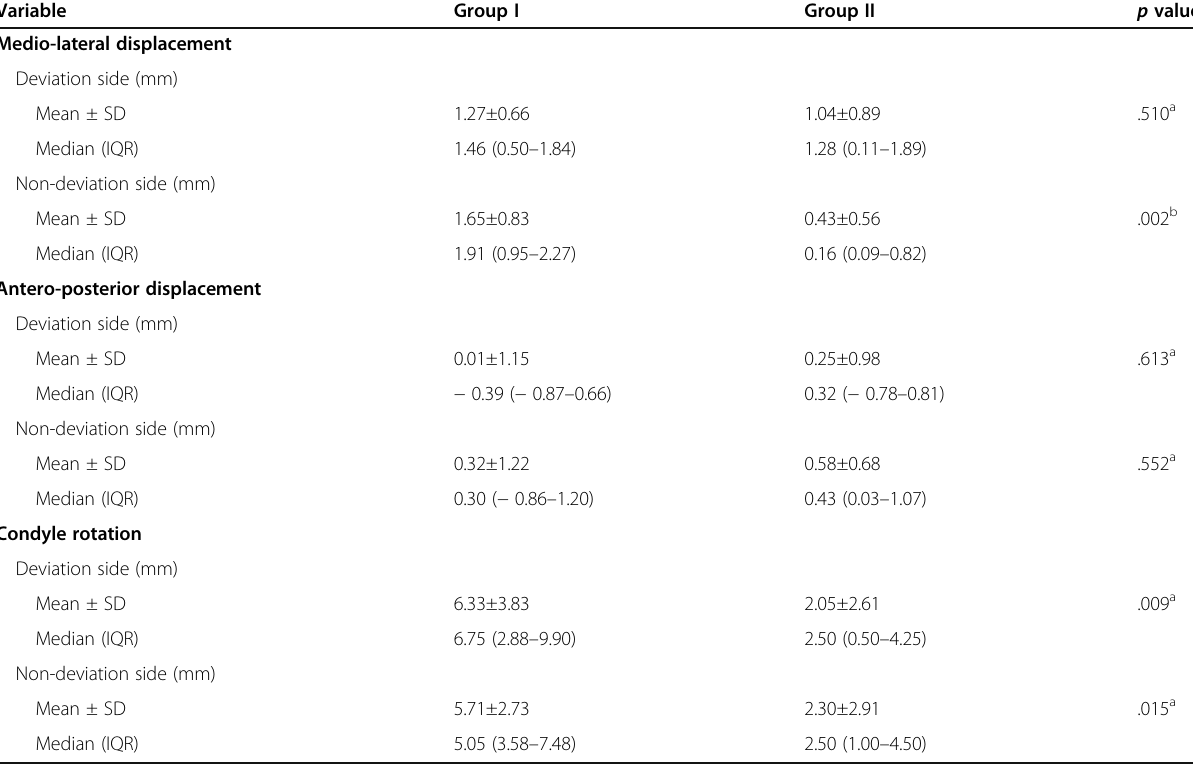
Table 2 Change in position of mandibular condyle of Group I and Group II